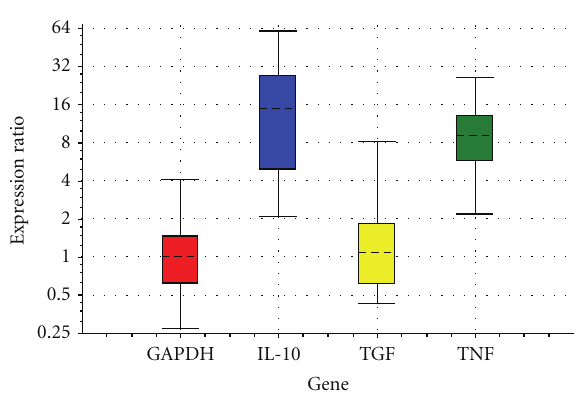
Figure 1: Relative expressions of IL-10, TGF- β 1, and TNF- α obtained from echinacea versus control after processing RT-PCR with REST in 20th day.